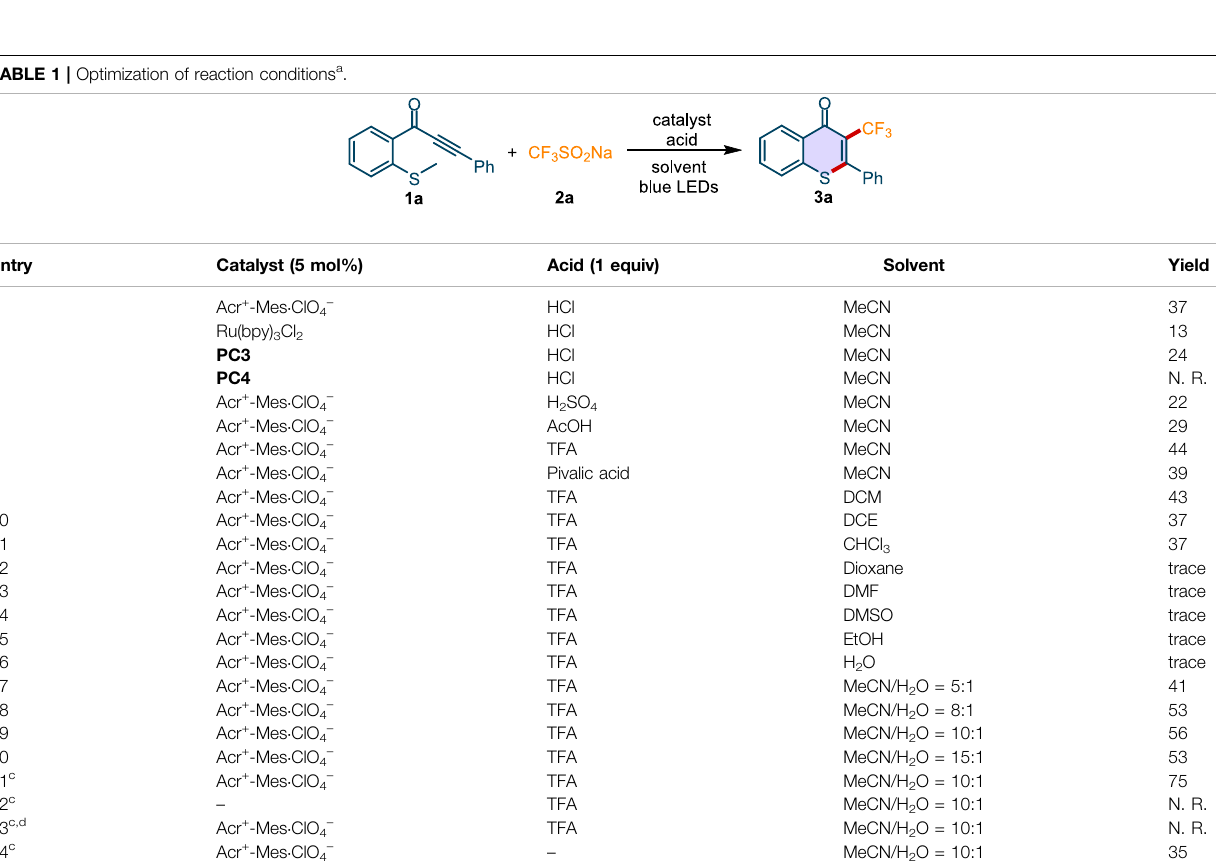
TABLE 1 | Optimization of reaction conditions a